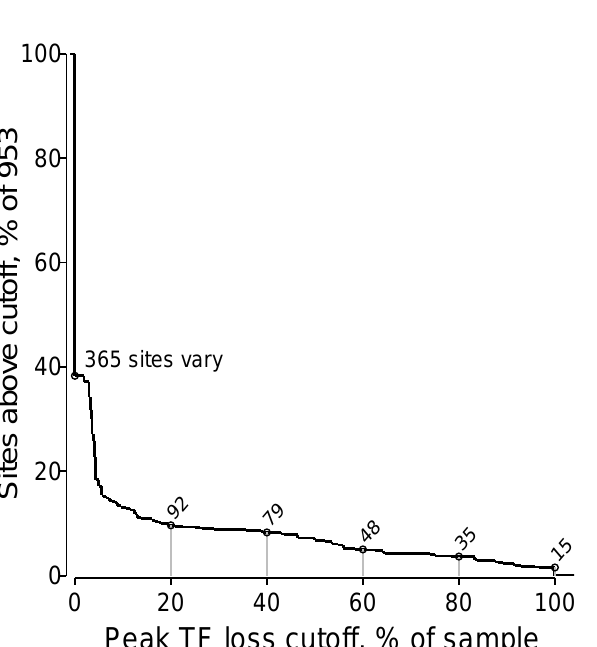
Figure 3. Cumulative distribution of peak TF loss over 953 aligned Env sites. Peak TF loss is the greatest proportion of non-TF variants in any time-point sampled, which corresponds to the minimum for each dashed line in Figure 2. Of 953 aligned sites, 365 (38.3%) varied and the others did not vary among sequences sampled throughout the period studied. We selected 35 sites with at least 80% peak TF loss for further study. Other cutoff values would yield more (e.g., 48 at 60% TF loss) or fewer sites (e.g., 15 at 100% loss) for